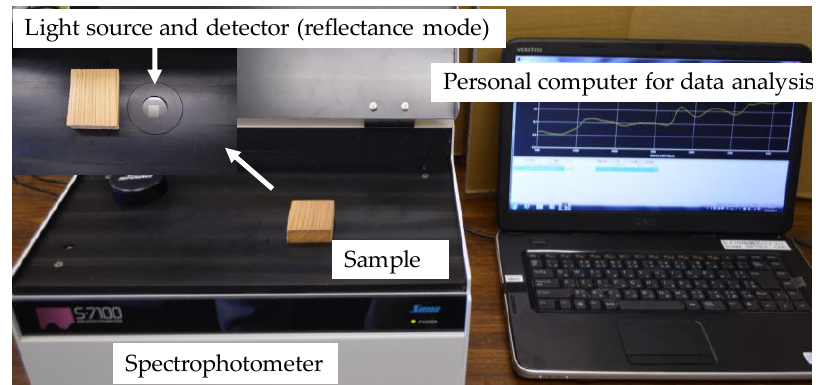
Figure 1. Outline of measurement device.